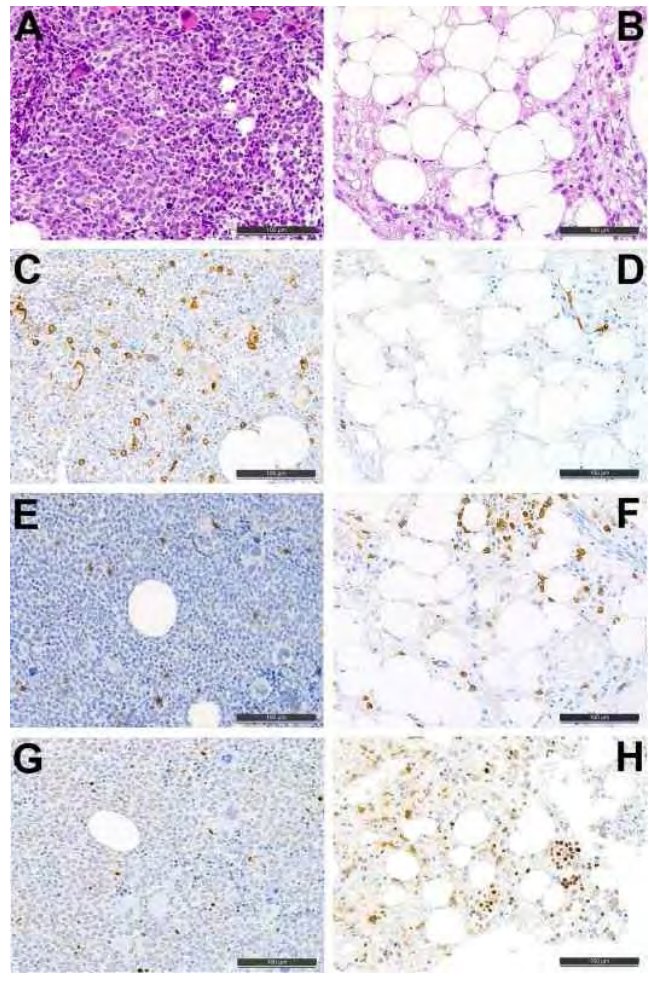
Figure 1: Pre- (left) and post-treatment (right) BM biopsies of a patient with